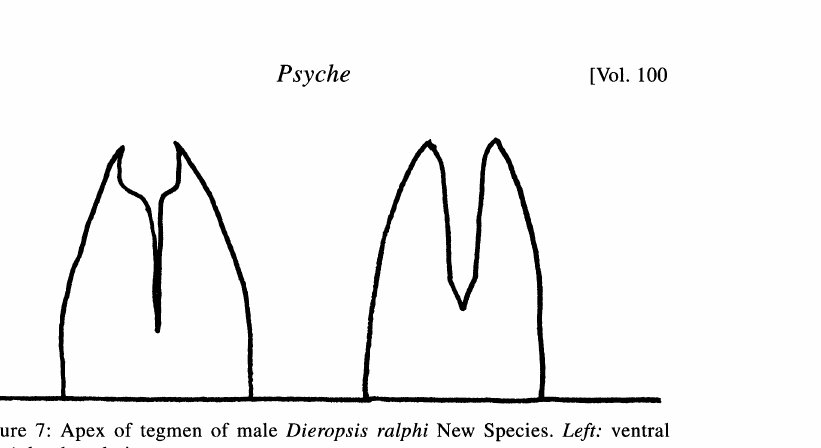
Figure 7" Apex of tegmen of male Dieropsis ralphi New Species. Left: ventral view; right: dorsal view.